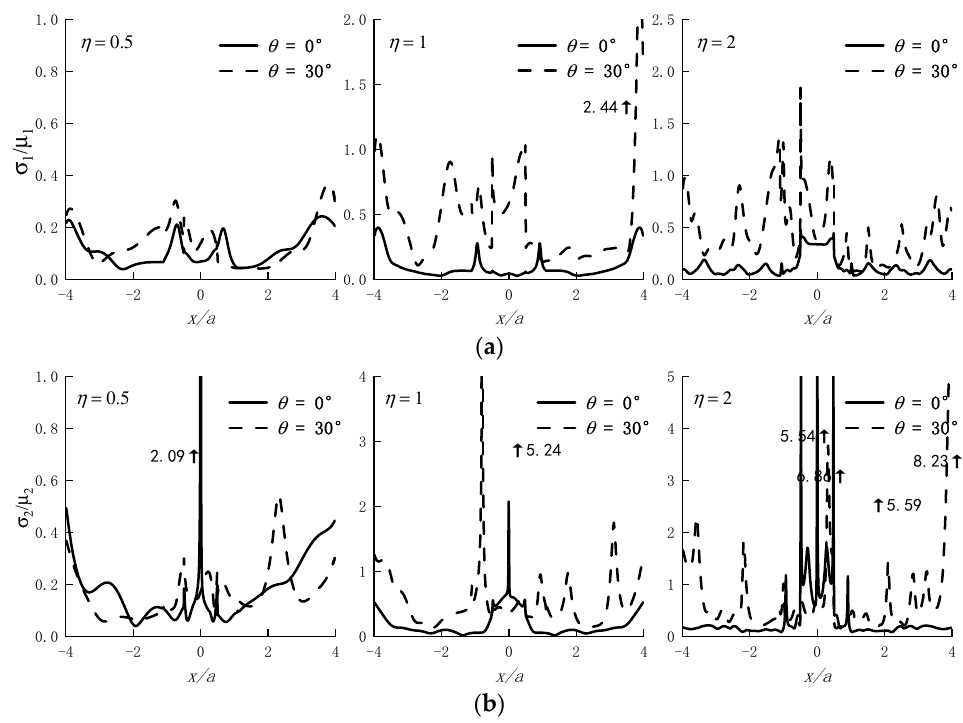
Figure 6. Coefficient of variation of surface displacement amplitude values for 100 sets of permeability coefficient samples. ( a ) Coefficient of variation of horizontal displacement; ( b ) Coefficient of variation in vertical